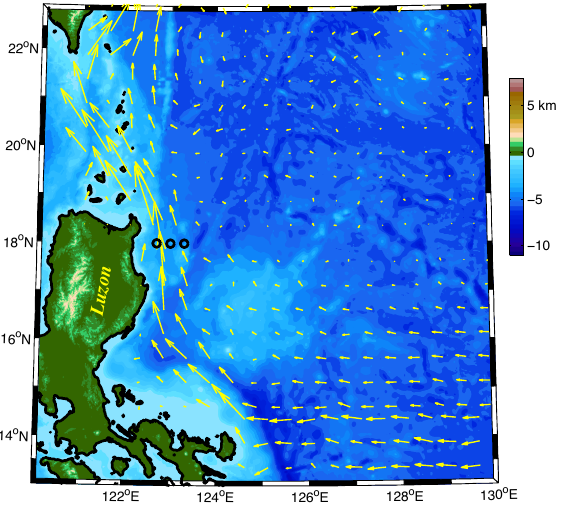
Figure 1. Bottom topography in the origin region of the KC. Black circles denote the moorings deployed at 122.7° E, 123° E, and 123.3° E along 18° N. Color shows the bathymetry of the western Pacific Ocean, which is downloaded from https:// downl oad. gebco. net/. The arrows represent the mean geostrophic currents (January 1993 to December 2019) from satellite altimetry (http:// www. marine. coper nicus. eu). Figures are plotted using MATLAB R2012b (http:// www. mathw orks. com/).